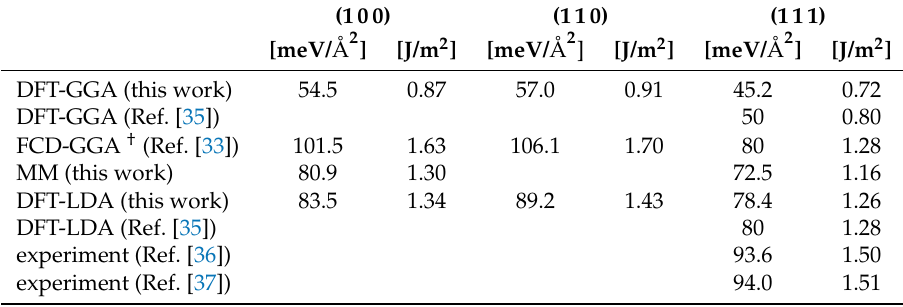
Table 1. Calculated surface energies for three low-index facets, including data from the literature for